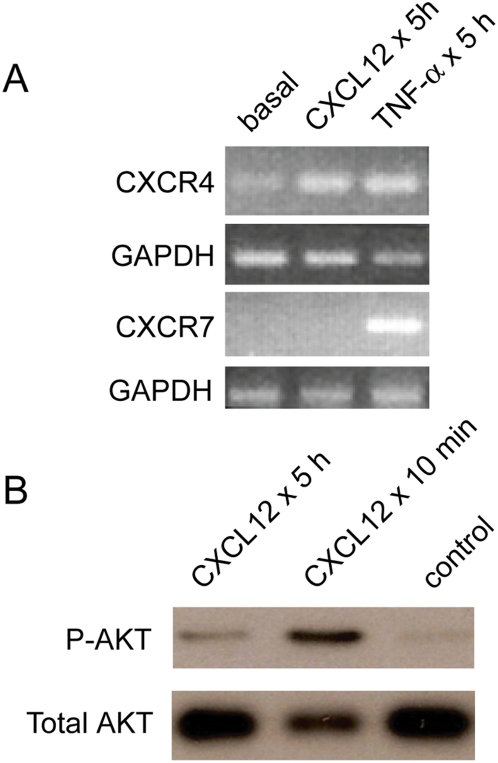
Characterization of CXCL12-mediated response in HDMECs.(A) Chemokine receptor expression in HDMECs determined by reverse transcription PCR (RT-PCR). HDMECs show expression of CXCR4 but not CXCR7 under basal conditions. CXCR4 on HDMECs is upregulated compared to basal conditions by CXCL12 and TNF-α. CXCR7 is upregulated by TNF-α only. RT-PCR for the housekeeping gene GAPDH confirms equivalent loading and intact RNA for all samples. (B) CXCL12 activates AKT in HDMECs as determined by Western Blot. There is CXCL12-dependent activation of AKT that remains greater than control endothelium through 5 hours.